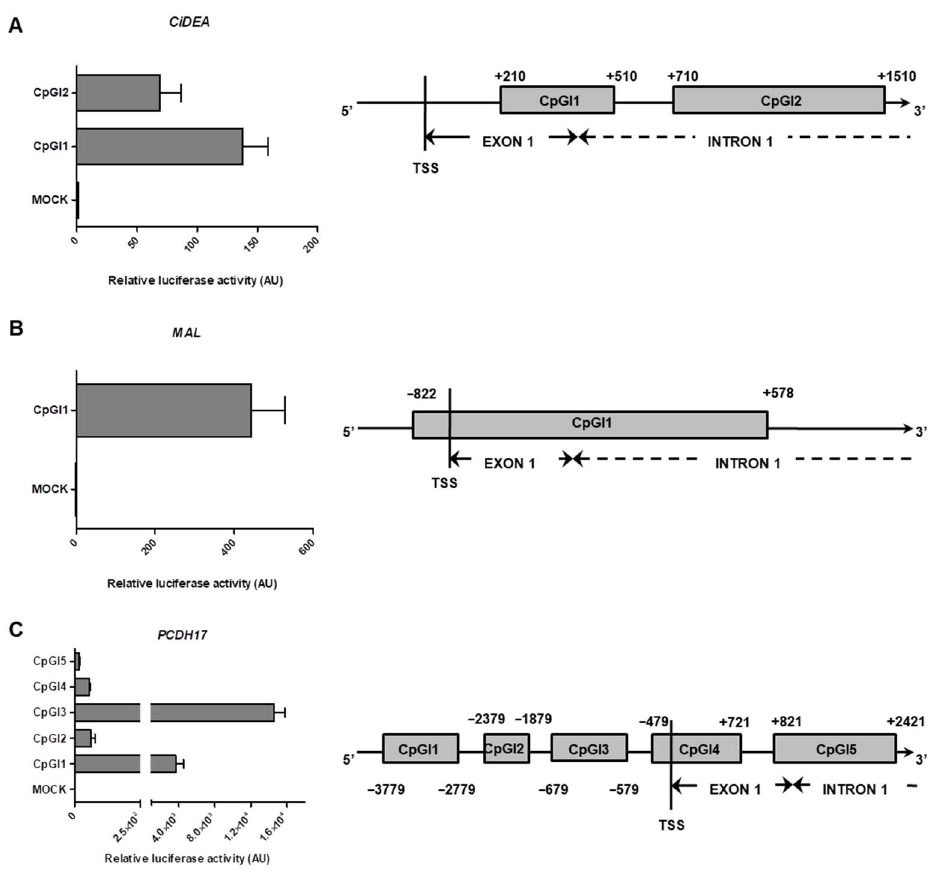
Figure 8. Luciferase assays of pCpGL-basic constructs containing CiDEA ( A ), MAL ( B ) and PCDH17 ( C ) CpG islands (CpGI) in CF2Th transfected cells. Luciferase activity values are expressed in arbitrary units (AU) as the fold activation relative to pCpGL-basic-mock-transfected cells (mean ± SEM of three independent experiments). On the right, a schematic diagram of CiDEA , MAL and PCDH17 gene structure and CpG-rich region position respect to the transcription starting site (TSS) is reported.